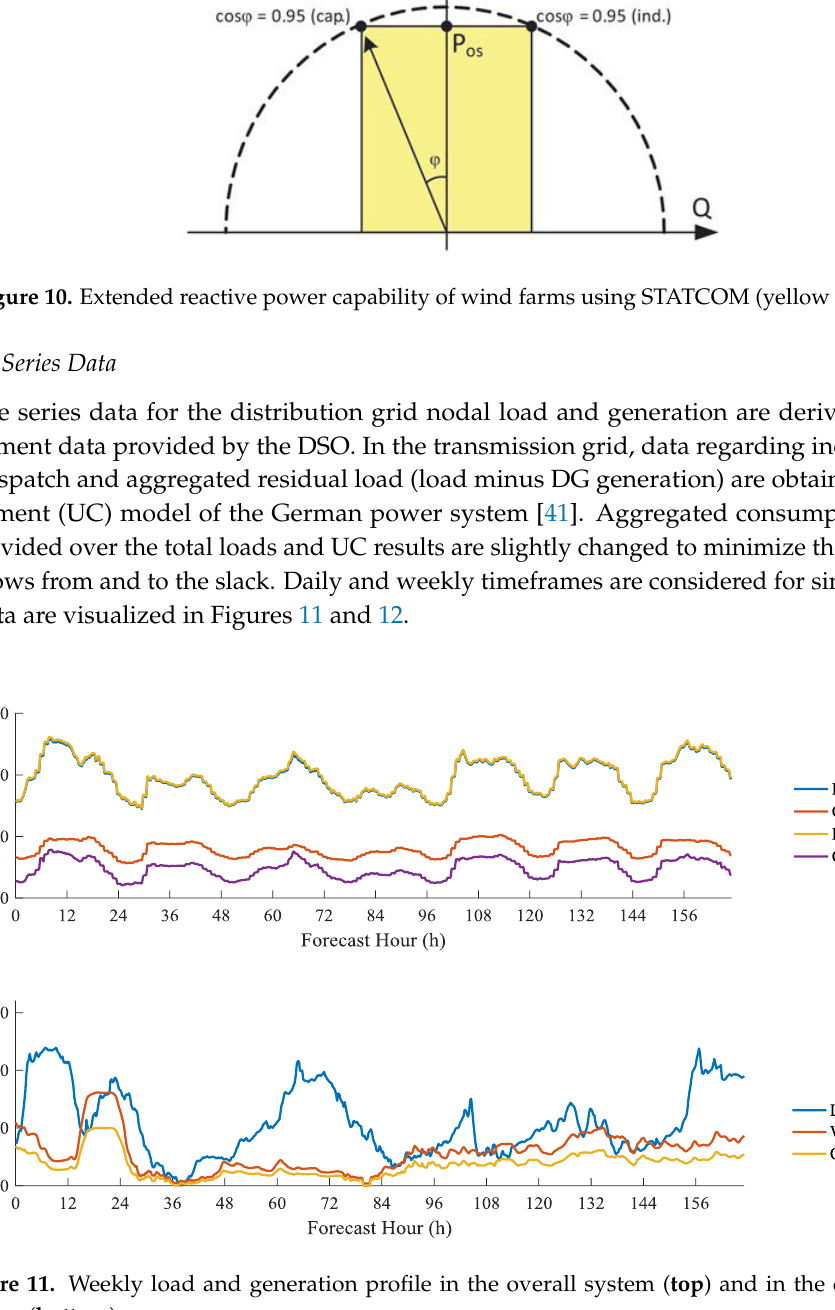
( b ) Figure 9. Transmission grid model in PowerFactory ( a ) (the arrow indicates the DSO grid position), and area of the distribution grid with CPs ( b ). In the transmission grid 15 synchronous generators and 3 static generators (off-shore wind farms) are modeled. In case of parallel generators, only one was considered in voltage regulation mode. In the distribution grid, all the 55 wind farms (1029 MW) connected to the 110 kV level are assumed to be equipped with remote control systems, and can therefore receive setpoints from the